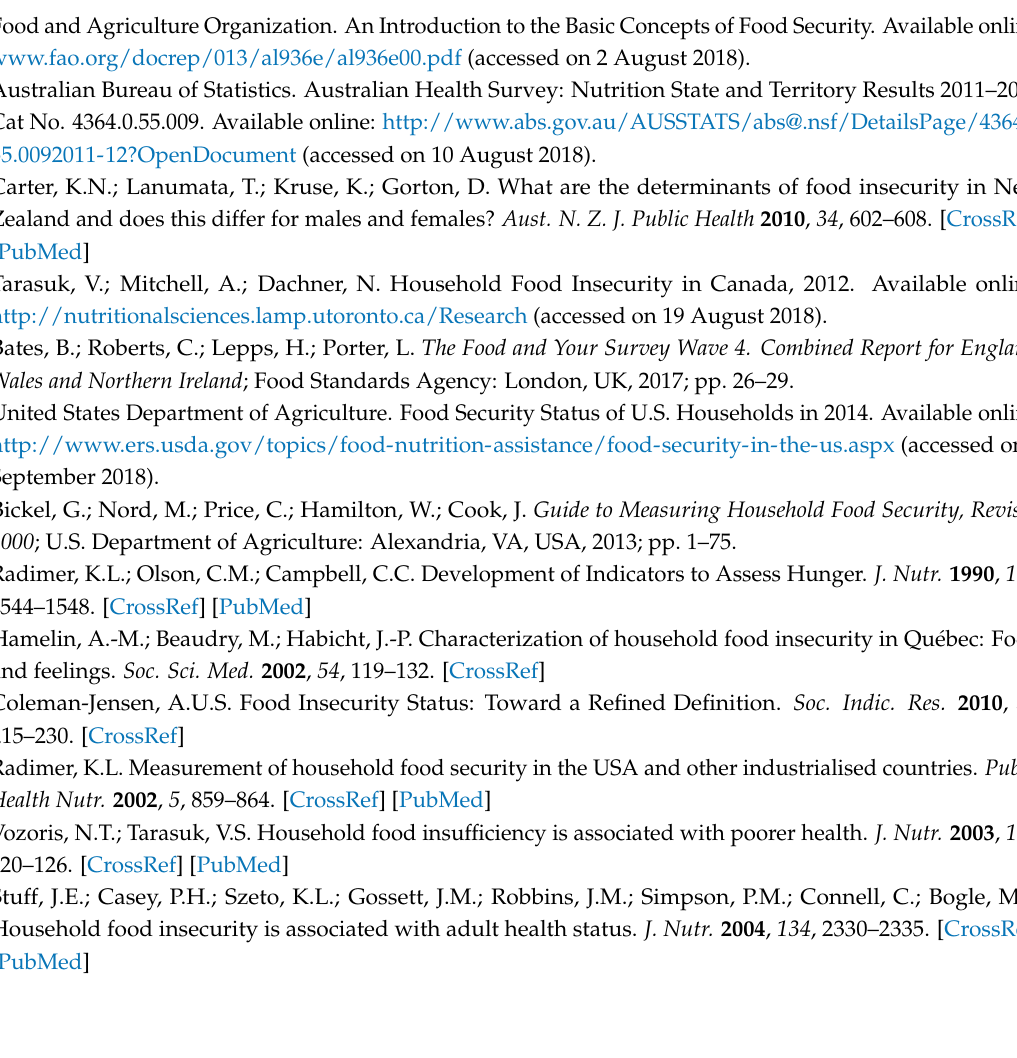
s1, Table S1: Quantitative United States Department of Agriculture Food Security Survey Module (18 items) and Qualitative Question